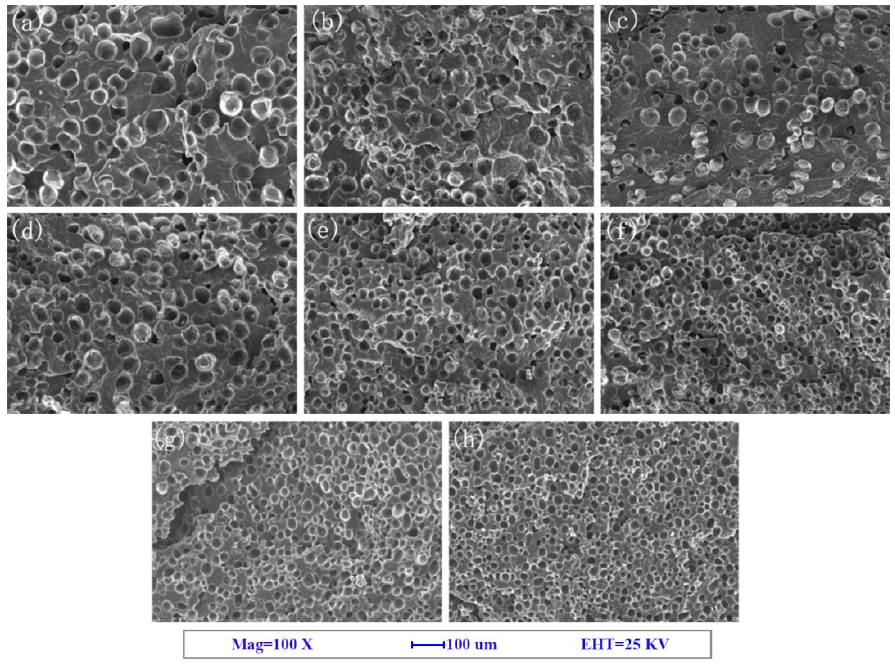
Figure 4. SEM images of the PP and PP + β -cyclodextrin (BC) (PB) composite foams: ( a ) PP, ( b ) PB0.25,